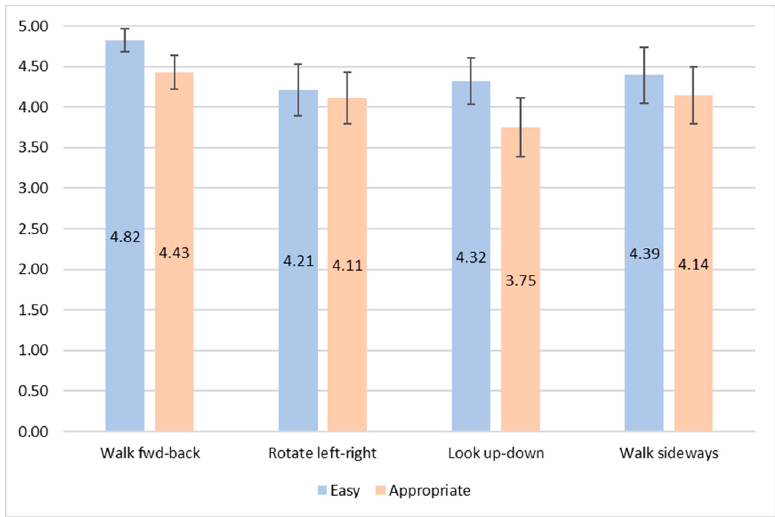
Figure 8. Mean values of subjective user ratings regarding the easiness and appropriateness of proposed gestures for each of the four tasks. Error bars represent 95% confidence intervals.